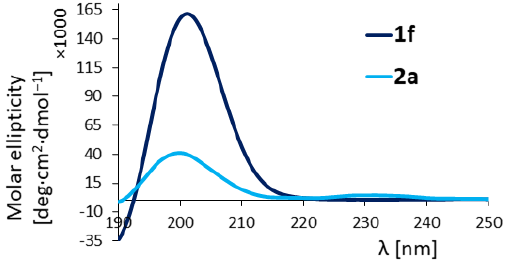
Figure 4. Circular dichroism spectra of compounds 1f (oligourea acid) and 2a (oligourea hydantoin) in TFE.